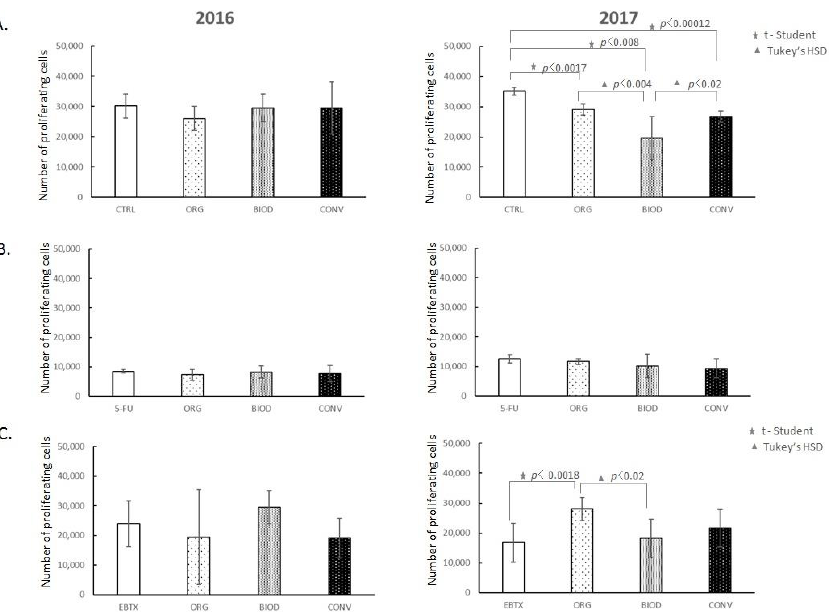
Figure 2. Blueberry extracts influence on the proliferation of HT-29 cells without and with anticancer drugs. ( A ) Effect of blueberry extracts alone; ( B ) Effect of blueberry extracts on the antiproliferative activity of 5-Fluorouracil (5-FU); ( C ) Effect of blueberry extracts on the antiproliferative activity of Erbitux (EBTX). CTRL—HT-29 cell culture without blueberry extracts; ORG, BIOD, CONV—HT-29 cell culture with blueberry extracts from particular types of the production system (ORG: organic, BIOD: biodynamic, CONV: conventional).